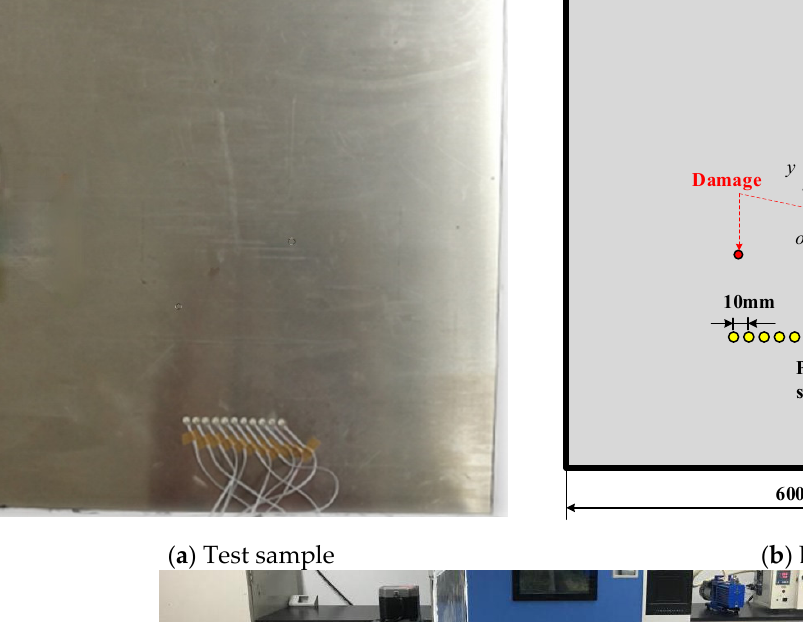
Figure 15. Comparisons of damage image between single and dual arrays.